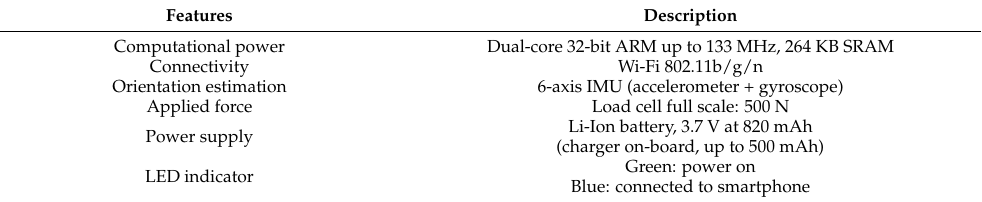
Table 1. mCrutch electronic characteristics summary.